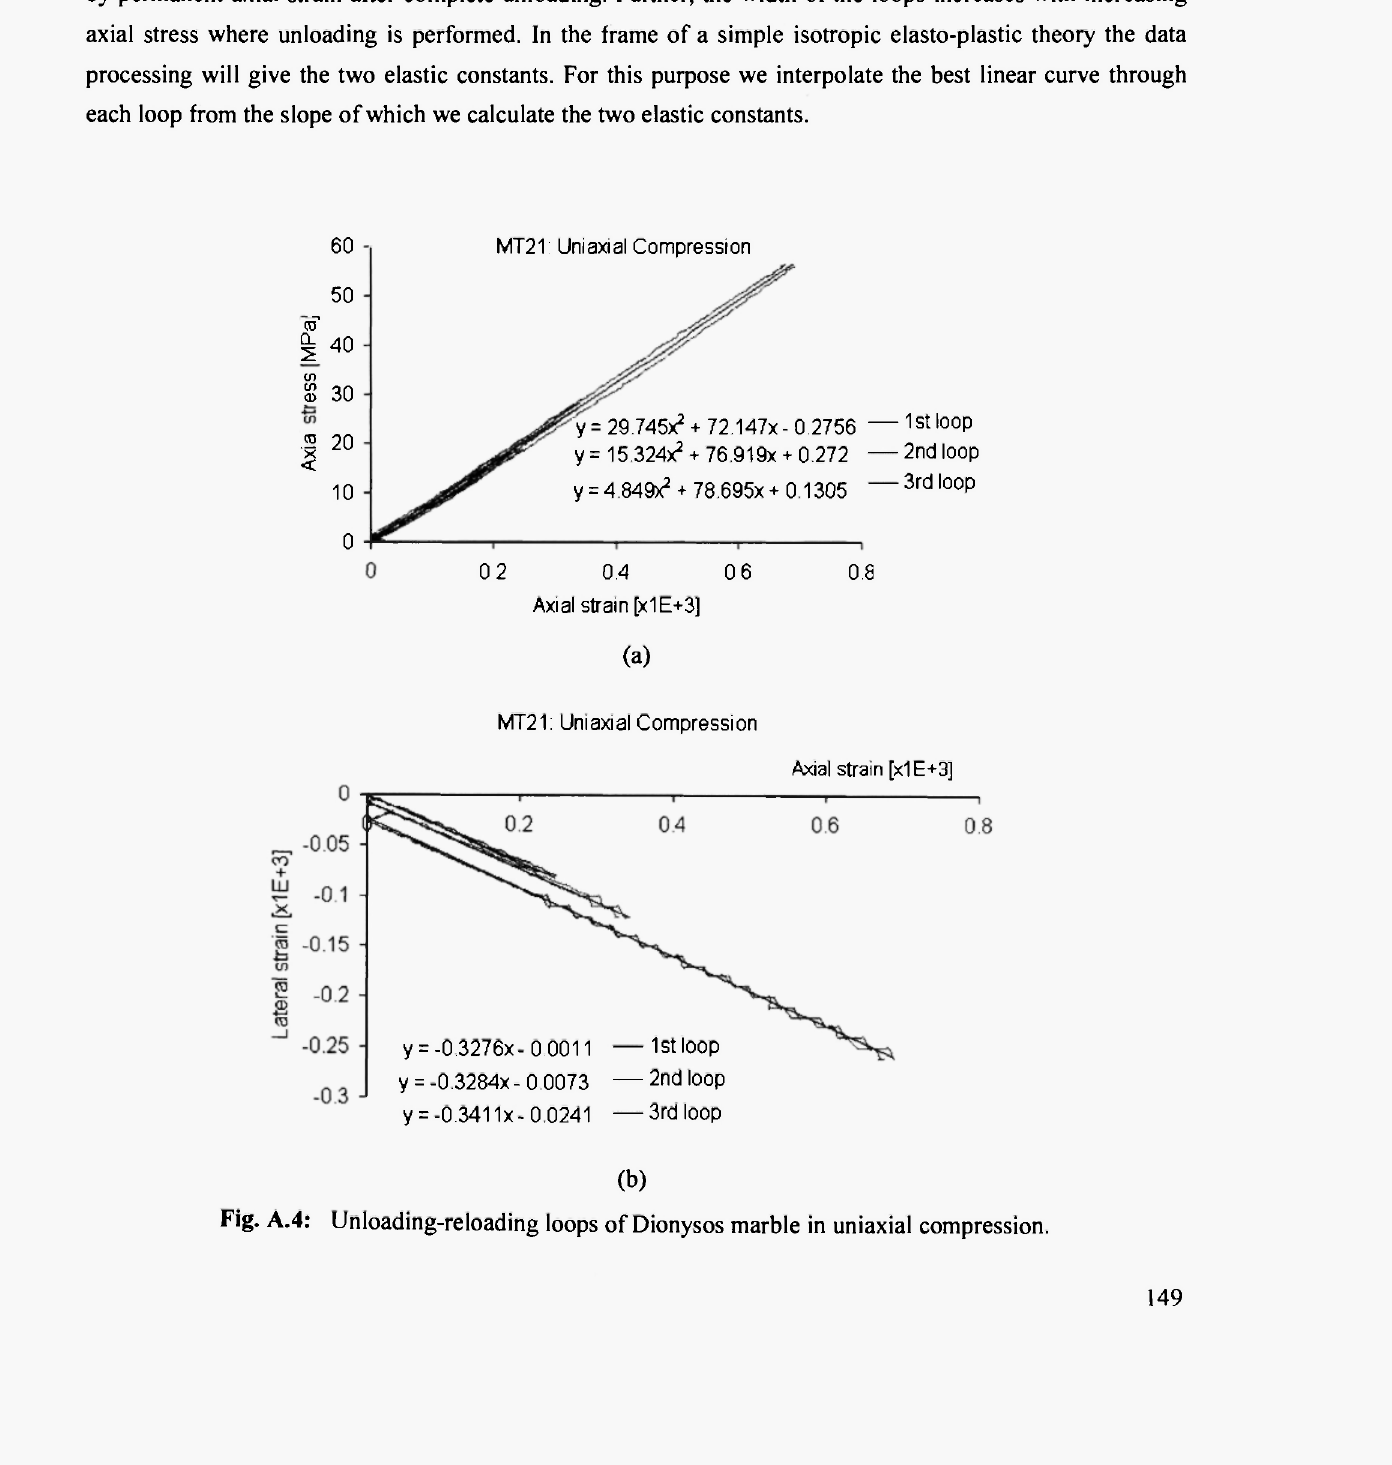
Fig. A.4: Unloading-reloading loops of Dionysos marble in uniaxial